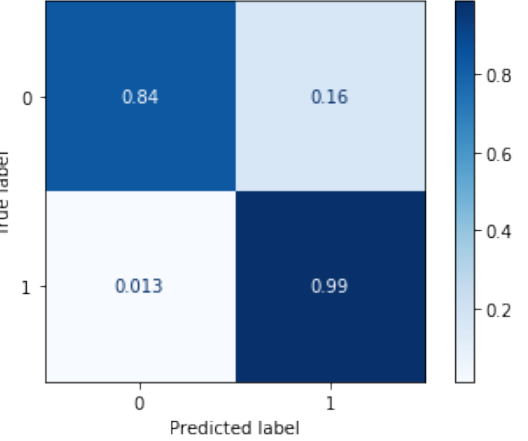
Figure 6. Classification performance evaluation. The normalized confusion matrix demonstrates the performance of the proposed model in classifying tiles containing obscurant clouds. The model tends to miss-classify tiles with tiles near the edge of the obscurant clouds since the human labels considered the edges clear although containing very light occlusion.